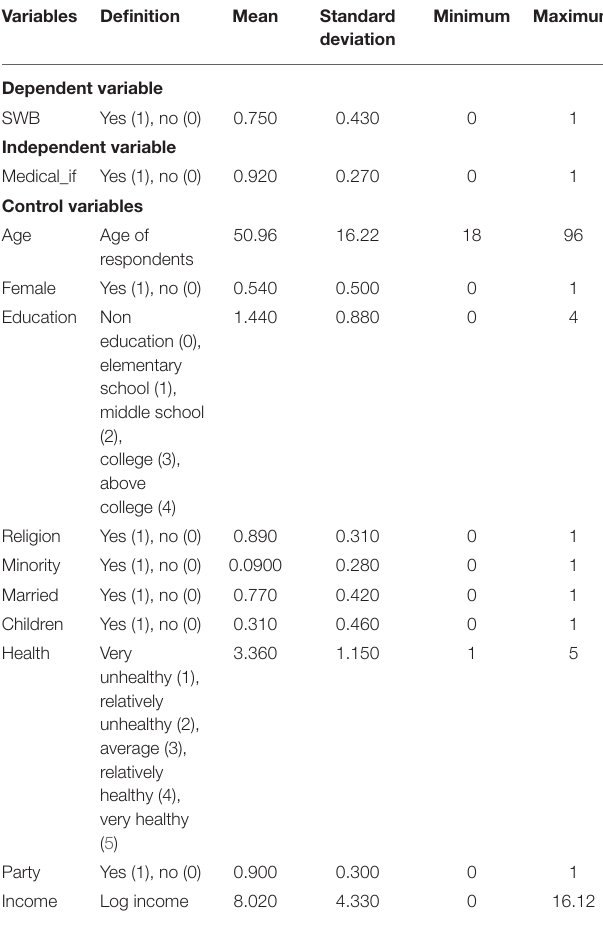
TABLE 1 | Variable description and descriptive